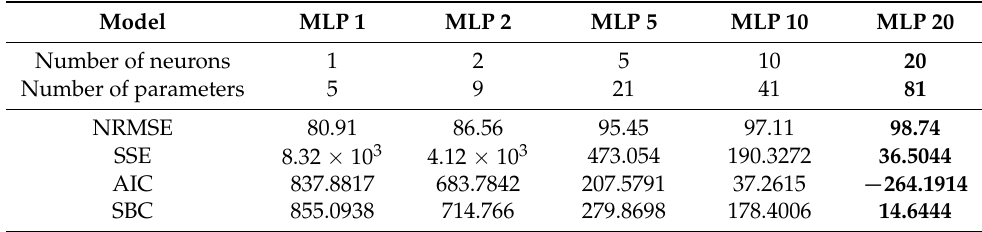
Table 13. Overview of the parameters of the created MLP models and performance metrics of the DMSP-5 muscle validation results.